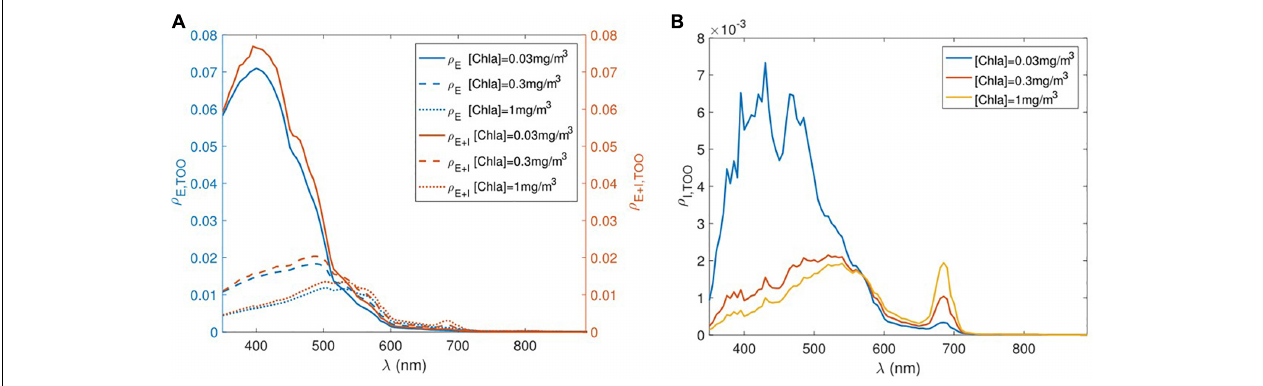
FIGURE 6 | (A) Ocean reflectance at nadir view at the top of the ocean (TOO) as a function of wavelength. (B) The absolute contribution of inelastic scattering to the TOO nadir reflectance as a function of wavelength. Subscripts E and I denote elastic and inelastic scattering,